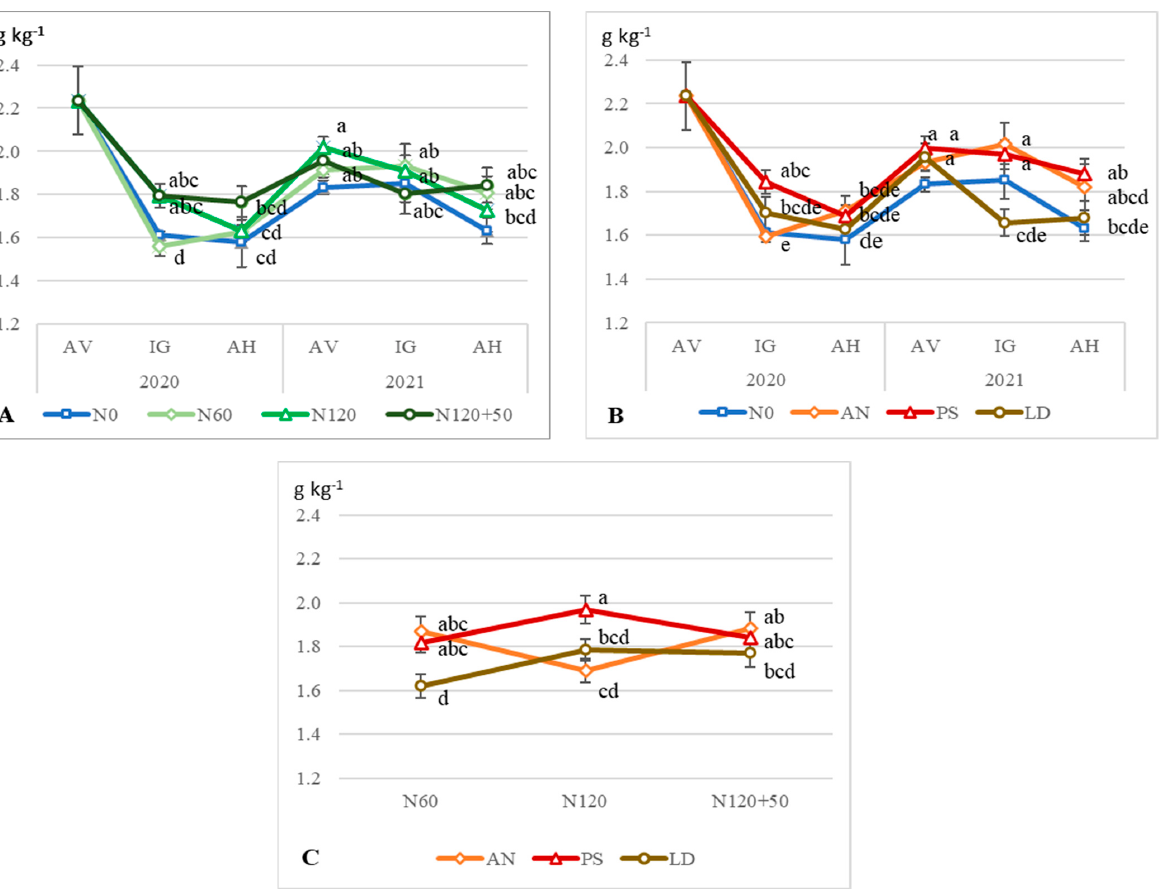
Figure 3. Variation in soil mobile humic substances (MHSs) (0–30 cm) during winter wheat growing season as influenced by different nitrogen rates ( A ), fertilizers ( B ), and their interactions ( C ). The standard error ( SE ) of the mean is used to represent error bars. Means with different letters within individual interactions are significantly different at the p < 0.05 level (N0 and AV2020 values were not included in the calculations; the letters are only implied). Abbreviations. Soil collection time: AV, at the beginning of winter wheat vegetation; IG, during intensive winter wheat growing (~1.5 months after AV and fertilization); AH, after winter wheat harvest. Nitrogen (N) rates: N0, unfertilized; N60, 60 kg N·ha − 1 rate; N120, 120 kg N·ha − 1 rate; N120+50, 120 + 50 kg N·ha − 1 rate. Fertilizers: N0, unfertilized; AN, ammonium nitrate; PS, pig slurry; LD, liquid anaerobic digestate.